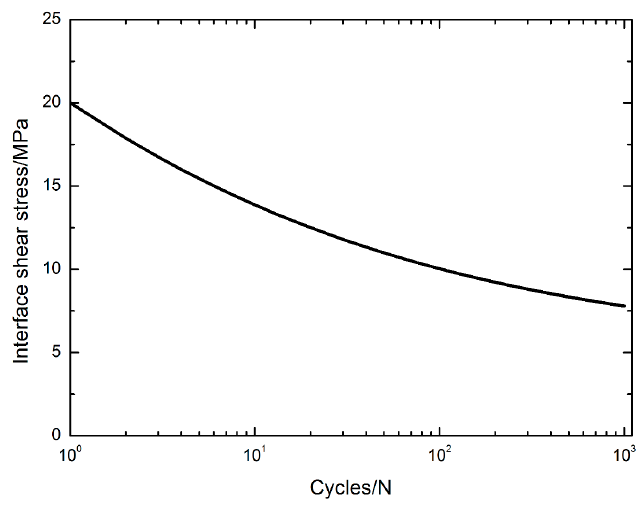
Figure 5. The interface shear stress degradation model.